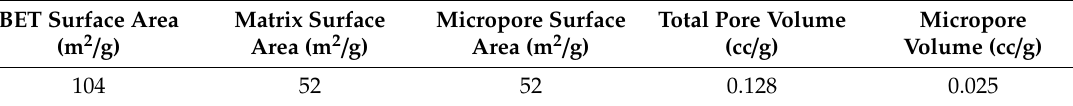
Table 1. Brunauer-Emmett-Teller (BET) analysis.